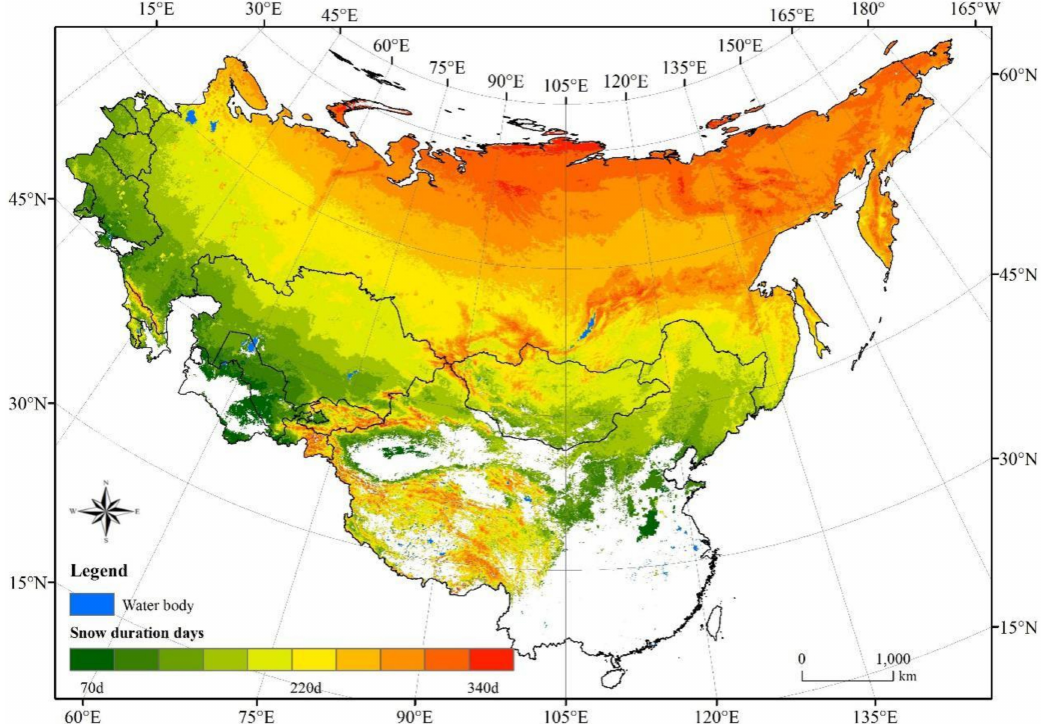
Figure 14. The spatial distribution of annual mean snow cover duration days (SDDs) in the study area from 2000 to